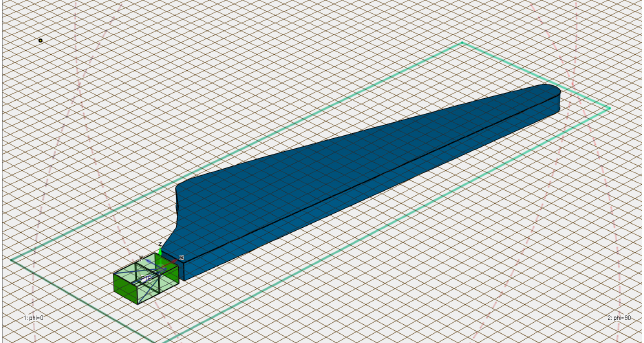
Figure 9. The source is not connected to the simple blade.